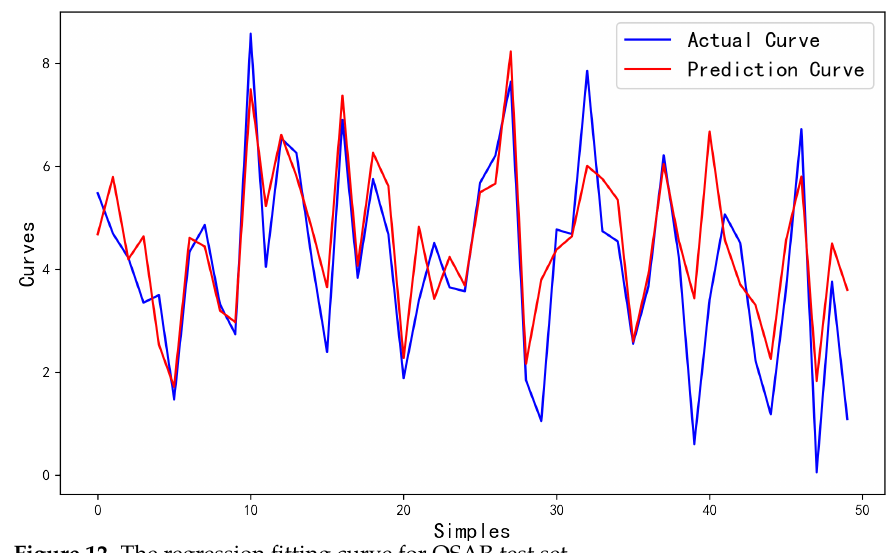
Figure 12. The regression fitting curve for QSAR test